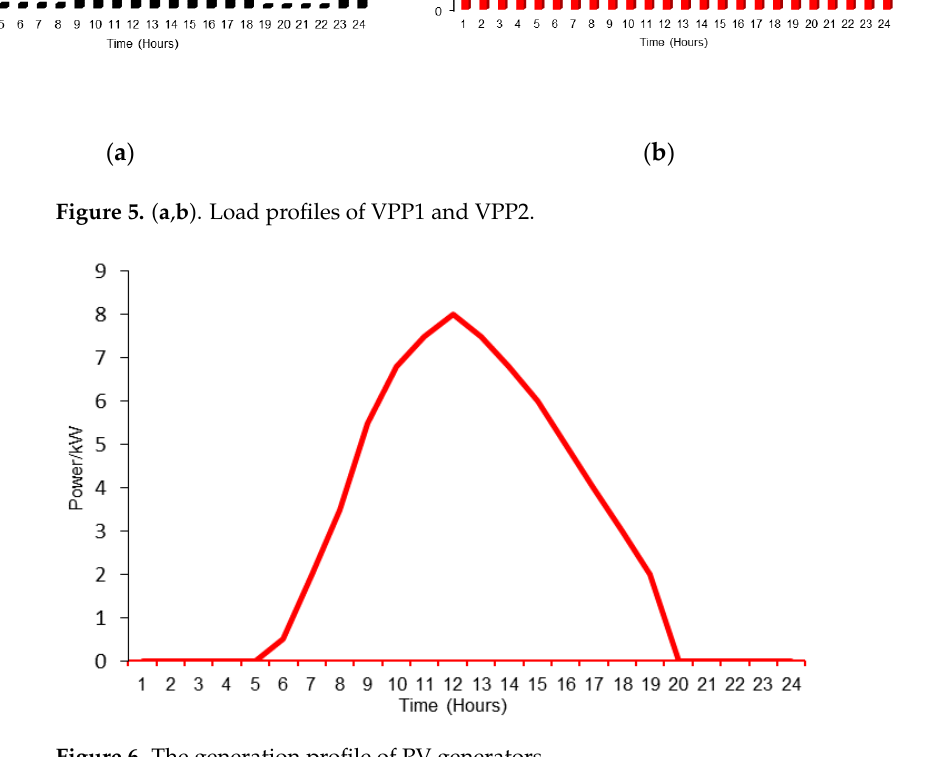
Figure 6. The generation profile of PV generators. Table 2. Parameters of